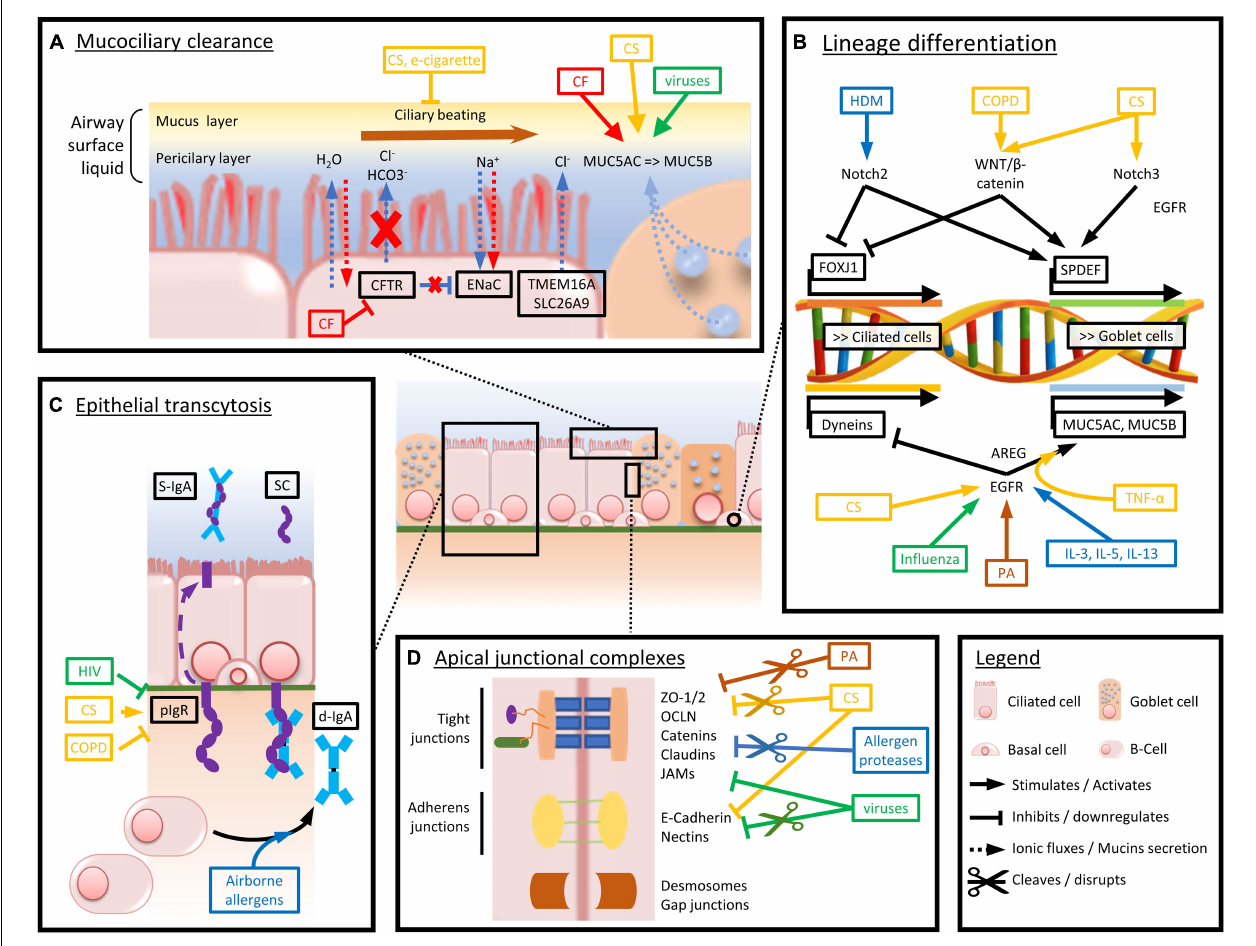
FIGURE 2 | Schematized view of the main mechanisms driving airway epithelium alterations in chronic respiratory diseases. Arrows and boxes are colored depending on the condition or disease driving the represented dysfunctions. Red stands for CF-induced abnormalities, yellow for CS and COPD, green for viruses, brown for bacteria, and blue for airborne allergens and asthma-associated cytokine panels. (A) Mechanisms altering mucociliary clearance and mucus composition in chronic respiratory diseases. (B) Main factors driving goblet cell hyperplasia and decreased ciliated cell numbers and function. (C) Mechanisms driving impaired pIgR expression and d-IgA basoapical transcytosis. (D) Mechanisms of altered physical barrier dysfunction (tight and adherens